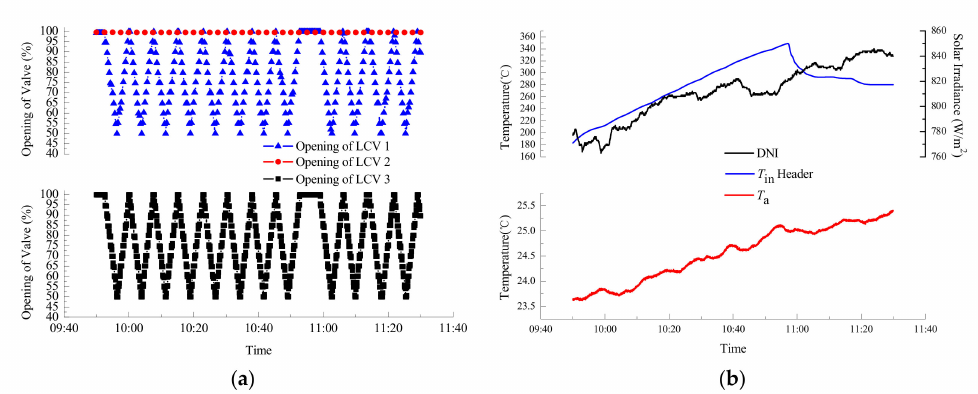
Figure 11. Measured data in the hot test: ( a ) opening of three LCVs and DNI; ( b ) ambient and header inlet temperature.